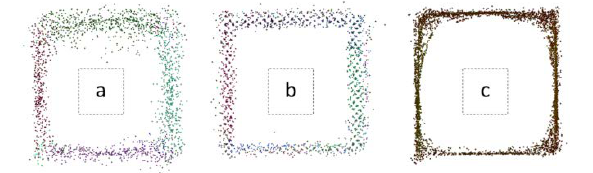
Figure 8 . Horizontal section of one column surveyed and post processed with a) oblique and horizontal sensors, b) oblique sensor only, c) as previous plus noise filter application.